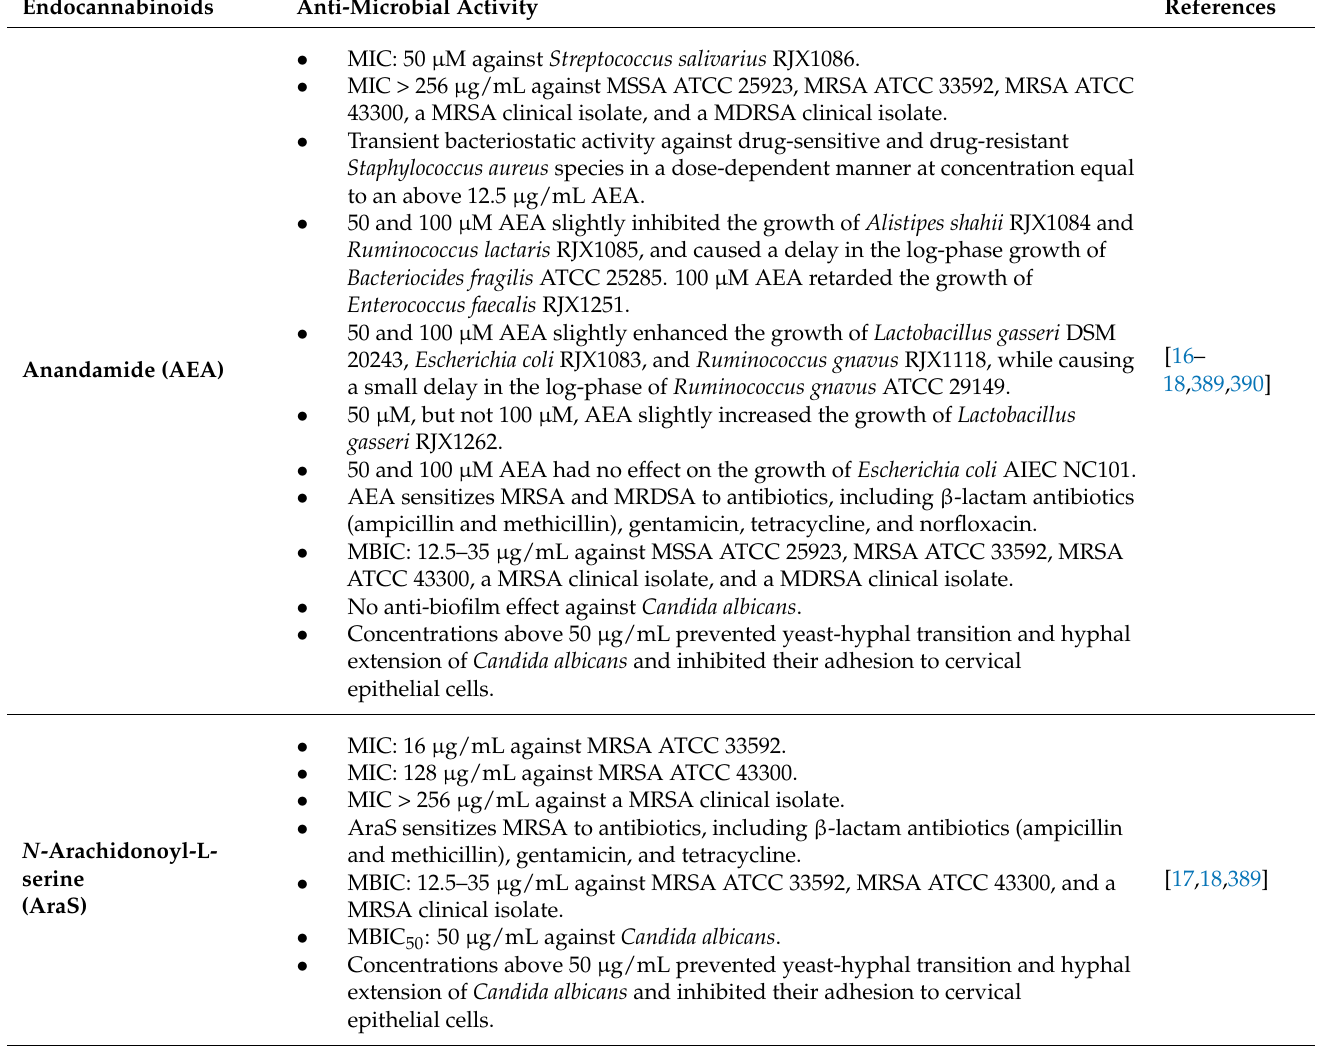
Table 2. Anti-microbial activities of endocannabinoids and endocannabinoid-like compounds. Endocannabinoids Anti-Microbial